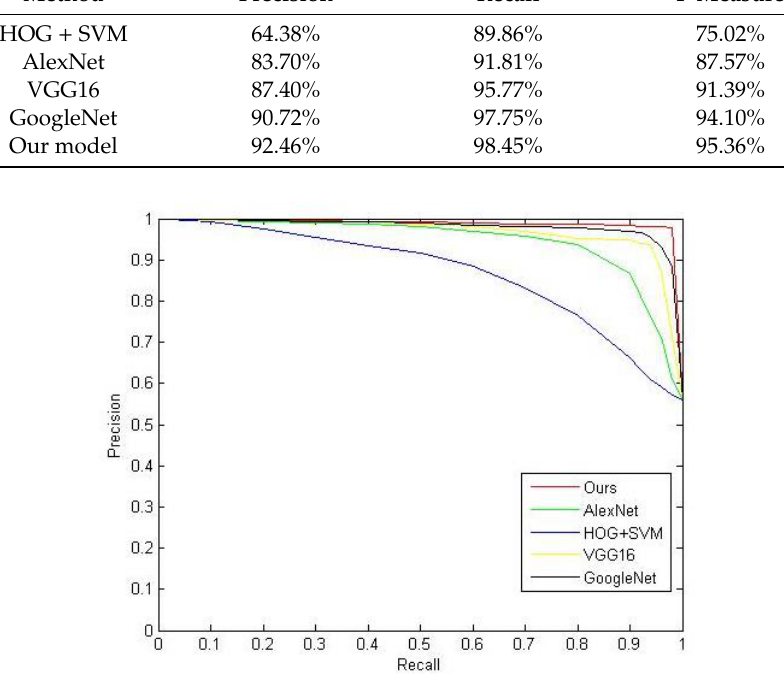
Figure 9. Precision–recall curves for recognition model.